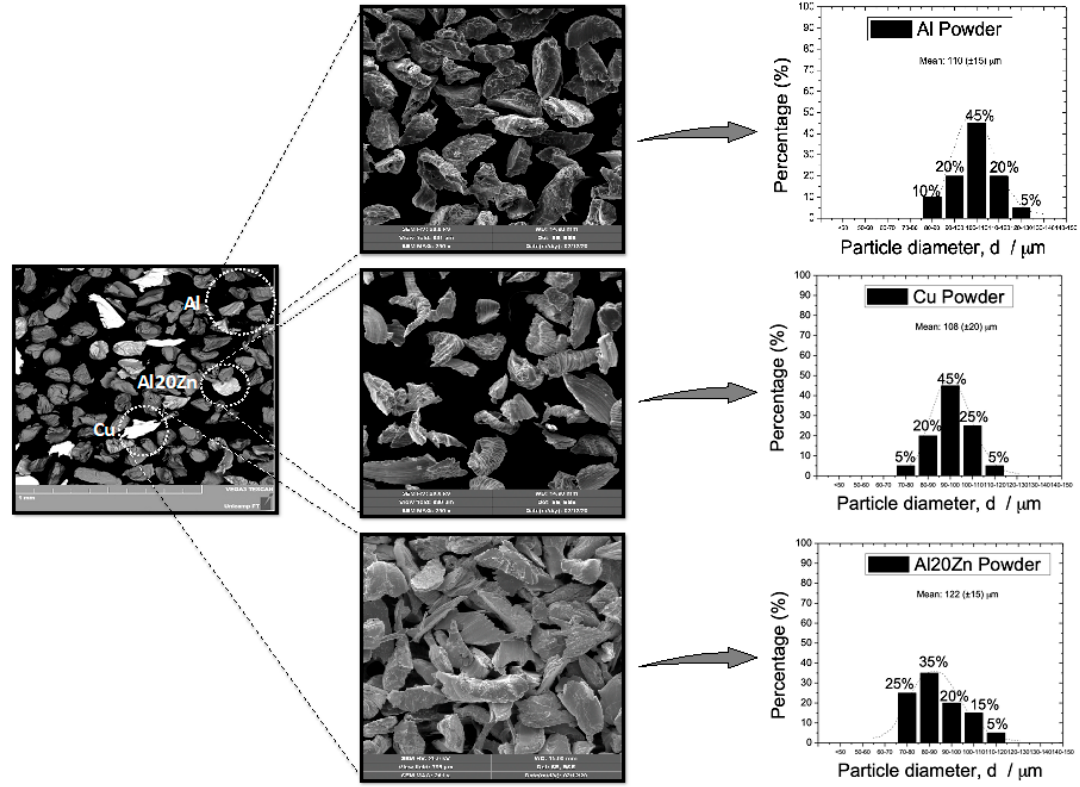
Figure 1. Typical SEM images of the morphology of Al, Cu, and Al20Zn powders and their blending to create the Al6Cu5Zn alloy (magnification of 250×).